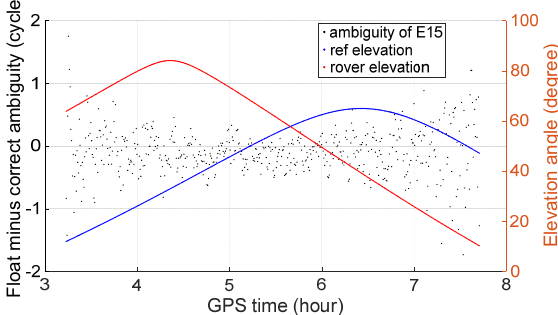
Figure 6. Ambiguity resolution of wide lane E15.